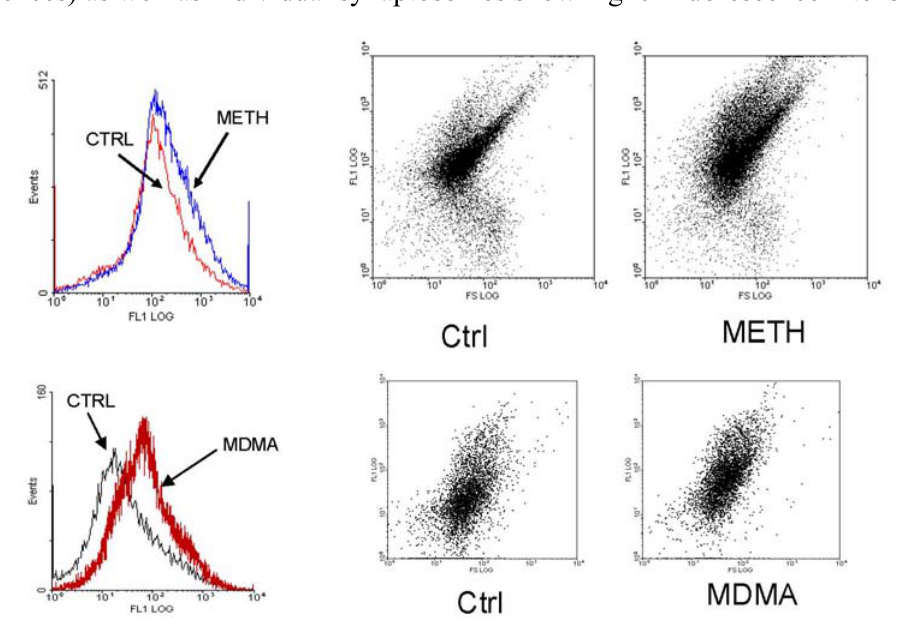
Figure 2. Representative fluorescence flow cytometry histograms and dot plots depicting the increase in ROS (DCF fluorescence) induced by previous incubation of rat striatal synaptosomes with METH or MDMA [29,79]. The histograms shift to the right (higher fluorescences) as well as individual synaptosomes show higher fluorescence